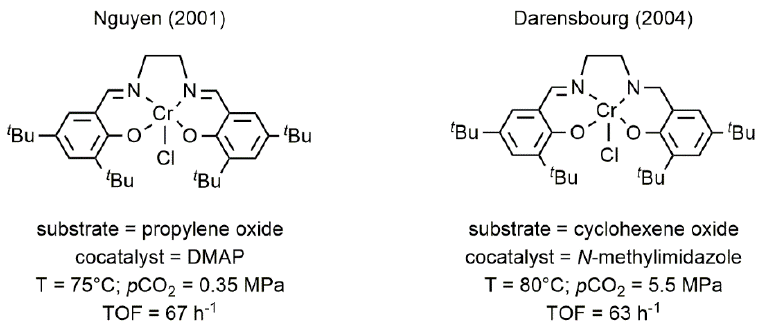
Figure 5. Chromium(III) Salen complexes for the reaction of CO 2 with CHO or propylene oxide (PO) [54,55].